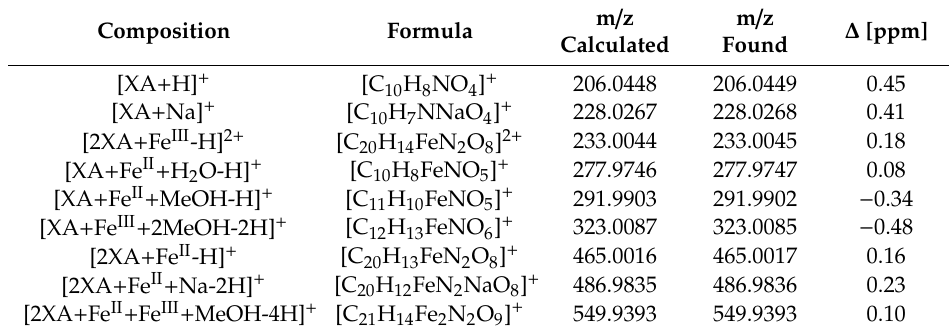
Table 2. The main signals of 56 Fe-XA coordination complexes in the solutions of XA with Fe II analyzed by nano-ESI-MS; a positive ionization mode.